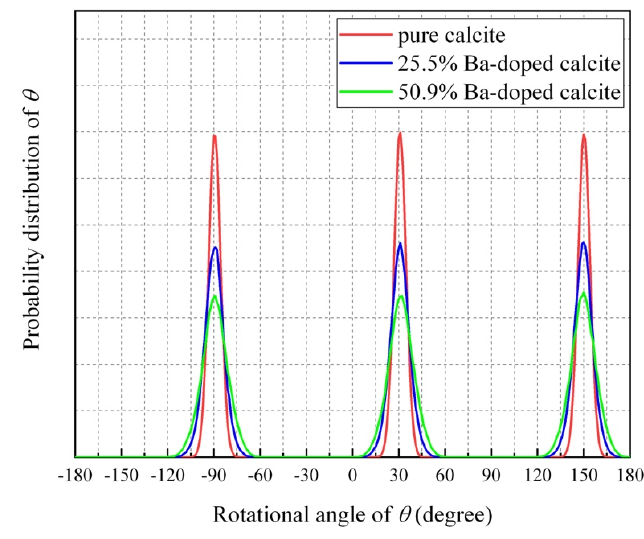
Figure 6. Disappearance of 113 reflection observed from powder X-ray patterns of ( a ) Sr-doped calcite samples and ( b ) Ba-doped calcite samples.